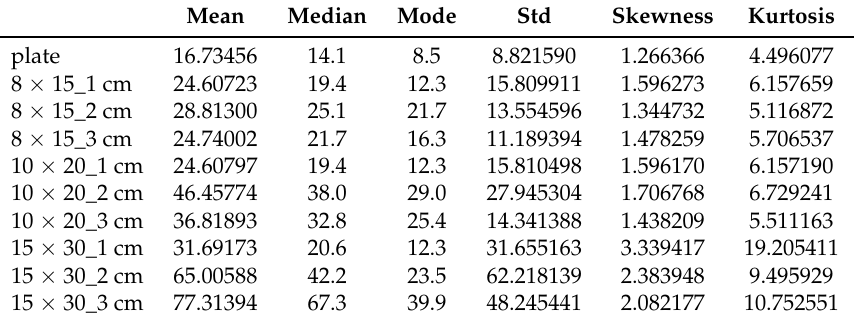
Table 2. Statistics for the timing of brine shrimp agents entering the blue zone by model. All values are given in units of seconds, and both skewness and kurtosis are calculated as Pearson standardized moments.